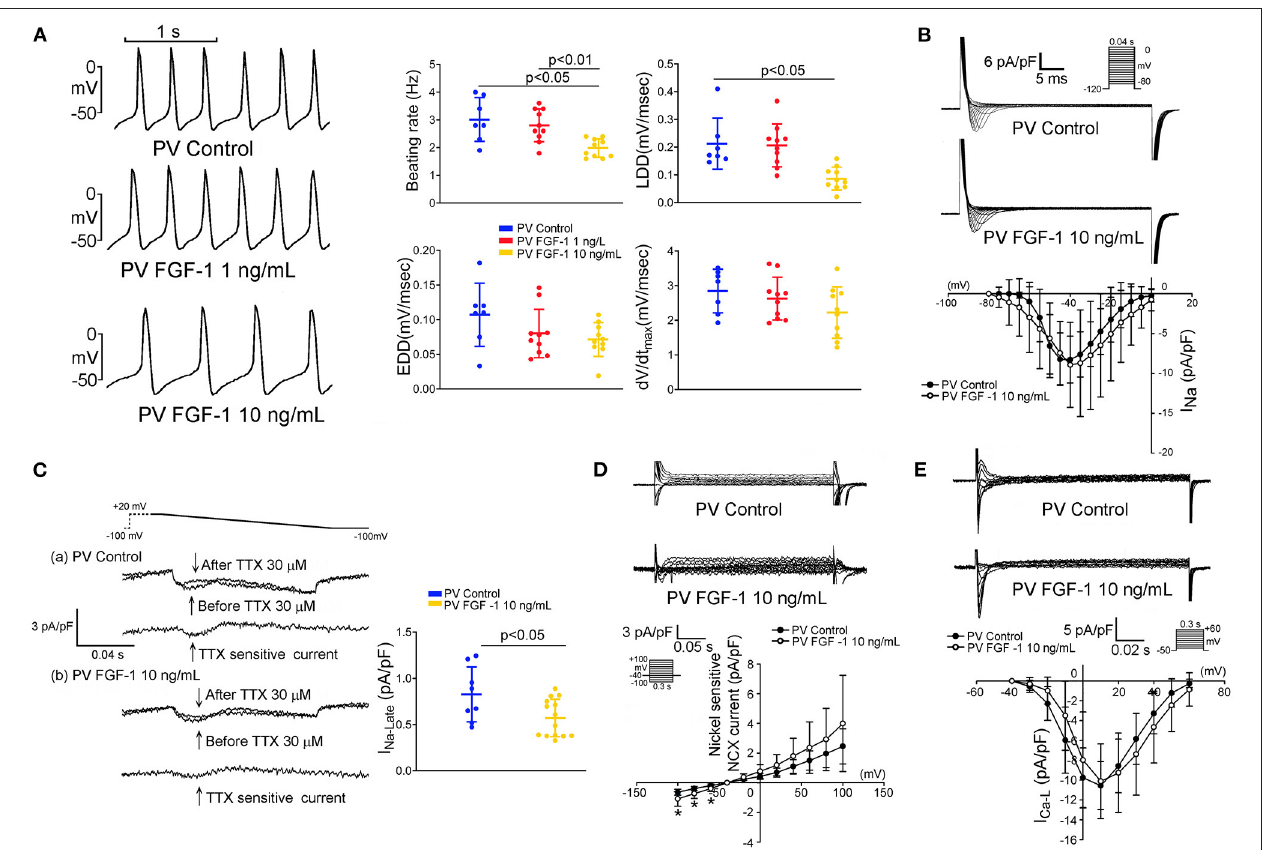
FIGURE 3 | Effect of fibroblast growth factor 1 (FGF1) on spontaneous activities, sodium (Na + ) current ( I Na ), late Na + current ( I Na − Late ), sodium–calcium exchanger (NCX), and L-type calcium current ( I Ca − L ) of pulmonary vein (PV) myocytes. (A) Examples of current traces and scatter plots of beating rate in the control ( N = 7) and FGF1 (1 and 10ng/mL)-treated PV myocytes (both N = 10). (B) Examples of current traces and scatter plots of I Na in the control ( N = 8) and FGF1 (10ng/mL)-treated PV myocytes ( N = 9). (C) Examples of current traces and scatter plots of I Na − Late in the control ( N = 8) and FGF1 (10ng/mL)-treated PV myocytes ( N = 14).